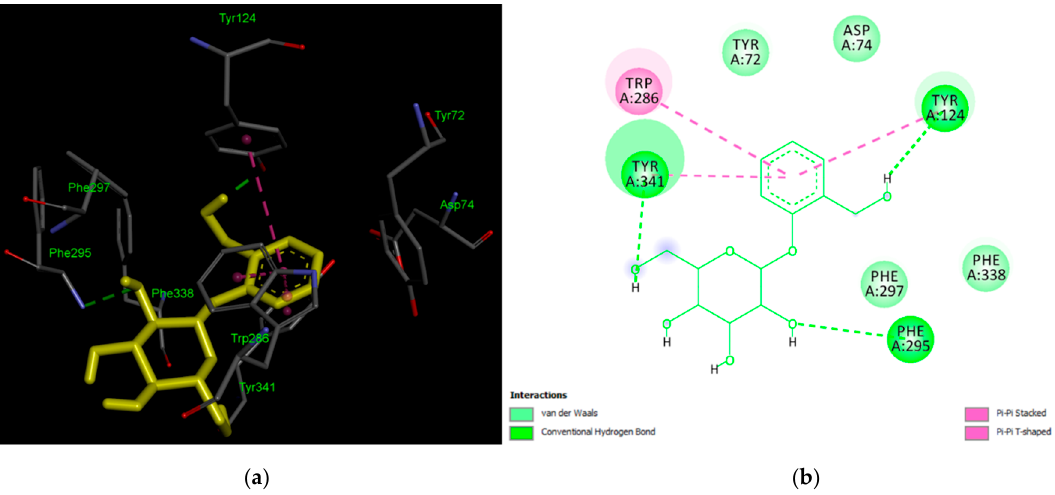
Figure 5. Active site of the AChE enzyme with salicin: ( a ) 3D view; ( b ) 2D view.